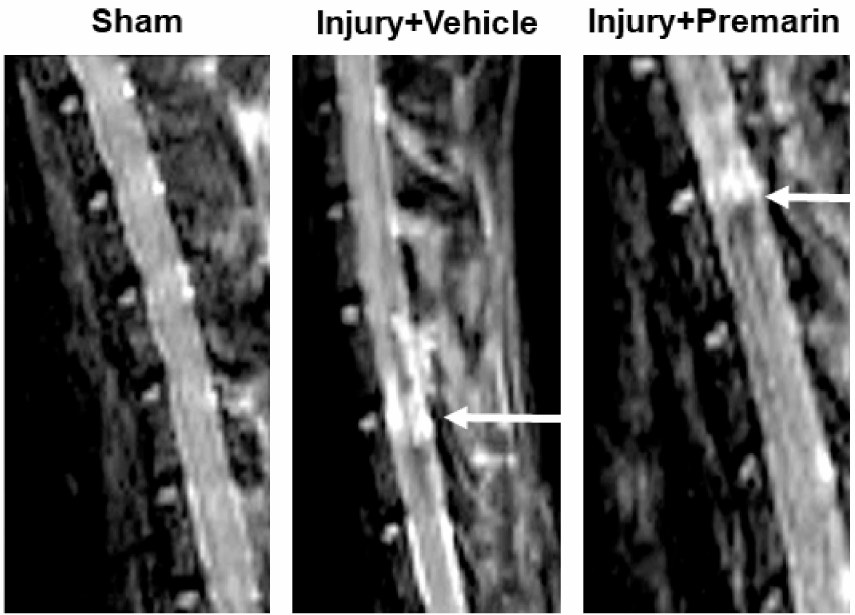
Figure 2. PRM reduces edema and preserves tissue integrity at day 7 following SCI. MRI imaging of spinal cords from sham and injury animals treated with either vehicle or PRM were imaged using a 7 Tesla (T) Bruker BioSpec USR system (Billerica, MA, USA). Imaging in the injured cords treated with vehicle clearly showed the injury lesion when compared to sham animals. PRM treatment decreased edema and preserved tissue integrity at injury site shown by a reduced lesion volume compared to that of the vehicle-treated injured rats. Lesion site is indicated by white arrow. The effects of PRM on neuronal death at 7-day post-SCI were assessed by double label immunofluorescent staining using NeuN (neuron marker, green) and TUNEL (apoptosis marker, red) in both the dorsal and ventral horn regions of the spinal cord (Figure 4A). TUNEL positive cells were absent in the sham animals treated with vehicle. The injured rats treated with vehicle showed extensive TUNEL positive cells in both dorsal and ventral regions of the spinal cord (Figure 4A, red arrows). Importantly, the majority of these cells co-stained for the neuronal marker NeuN (red arrows), suggesting neuronal death in vehicle treated injured rats. In contrast, PRM treatment led to a decrease in neuronal death indicated by the low number of TUNEL positive cells and increased number of NeuN positive cells (green arrows), and the effect was similar to that observed in E2-treated rats used as positive controls. While NeuN is predominantly found in the nucleus, it is also found in the cytoplasm of neurons. In Figure 4, the expression of NeuN is shown in both nucleus and cytoplasm. This is not surprising since partially damaged neurons in the caudal injured cord could release NeuN from the nucleus into the cytosol. Even treatment with E2 or PRM may not completely protect neurons, but they may remain functional. Since the staining was performed with the TUNEL, the localization of NeuN was not clearly marked with the